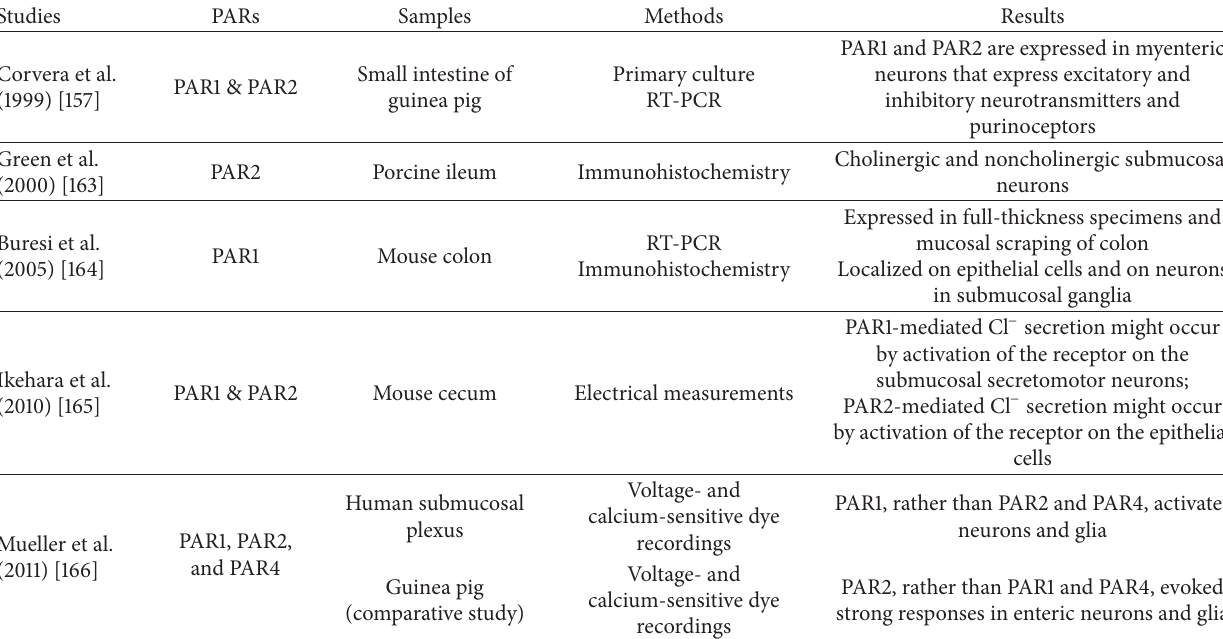
Table 1: Main findings of PAR